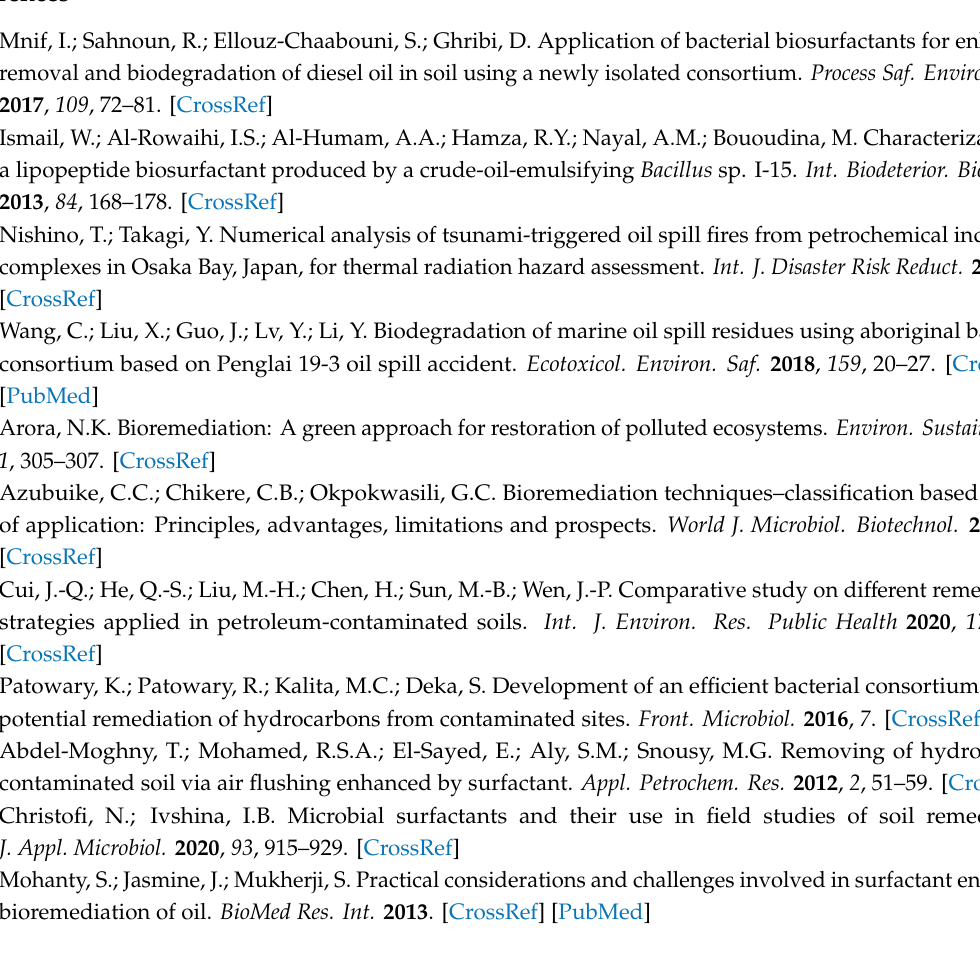
Figure S1: Percentage of TPH degradation, 16s rRNA gene copy / mL of culture, and surface tension reduction of consortia (a) C1, (b) C2, (c) C3, (d) C4, (e) C5, and (f) C6; of the 15th generation, Figure S2: The turbidity of culture among consortia C1, C2, C3, C4, C5, and C6 at the (a) 5th, (b) 10th, and (c) 15th generation, Table S1: